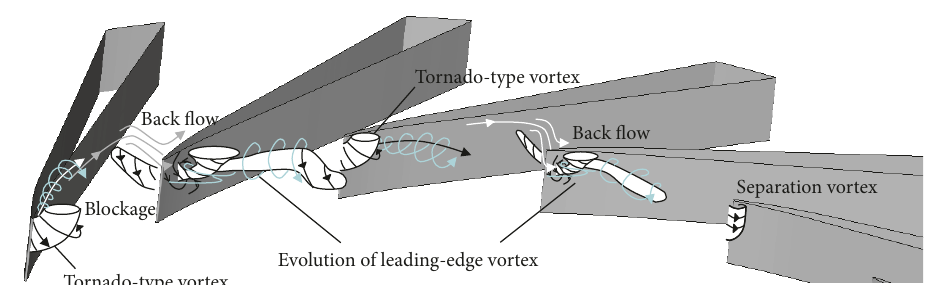
Figure 13: Illustration of rotating mechanism of diffuser stall cell.